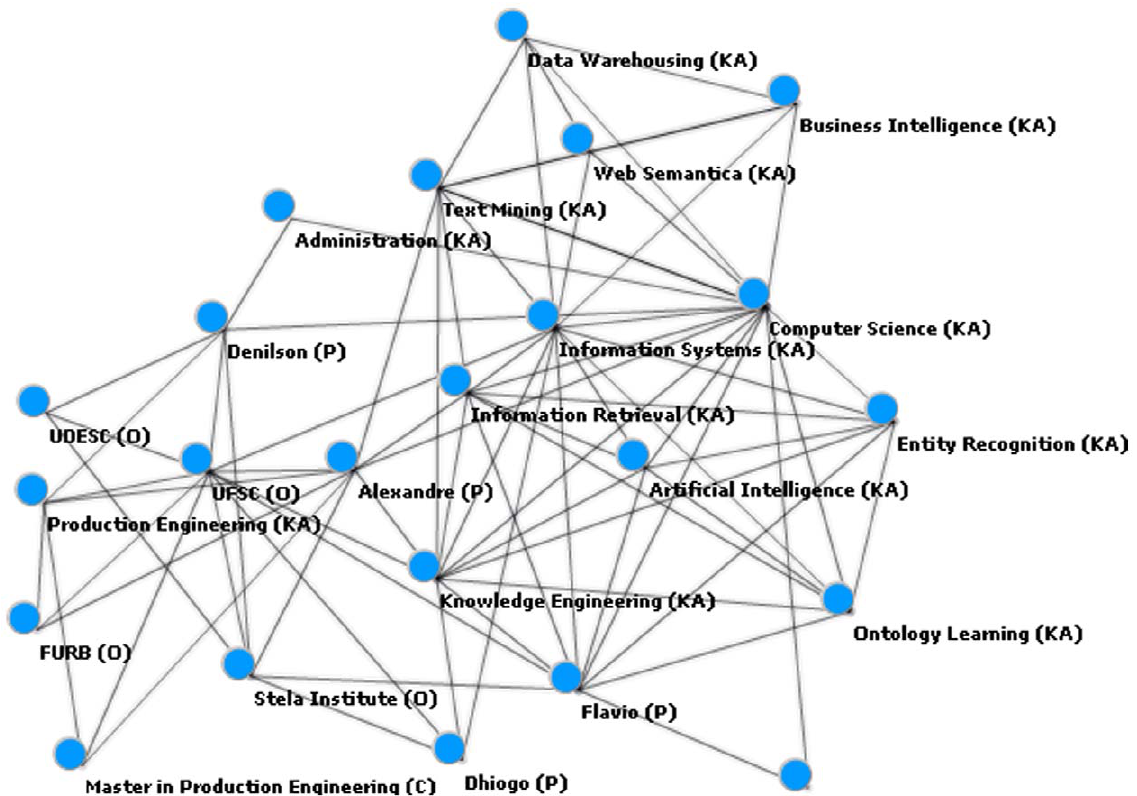
Figure 2. Resulting instances (classes) and their relations.